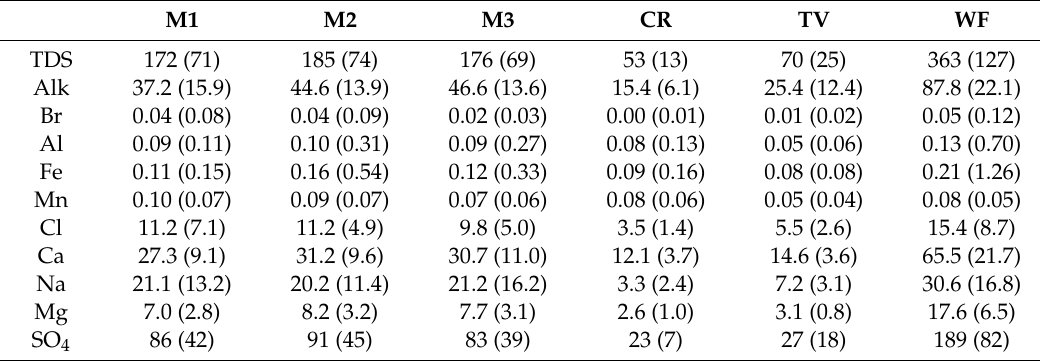
Table 2. Means (and standard deviations) of total dissolved solids (TDS) and its contributing constituents across all water samples taken within the Cheat (CR), Tygart Valley (TV), West Fork (WF), and Monongahela (M) Rivers. Refer to Figure 1 and Table 1 for site location and sample information. Means are reported in mg / L. Alkalinity (Alk) is reported in mg / L CaCO 3 equivalents. M1 M2 M3